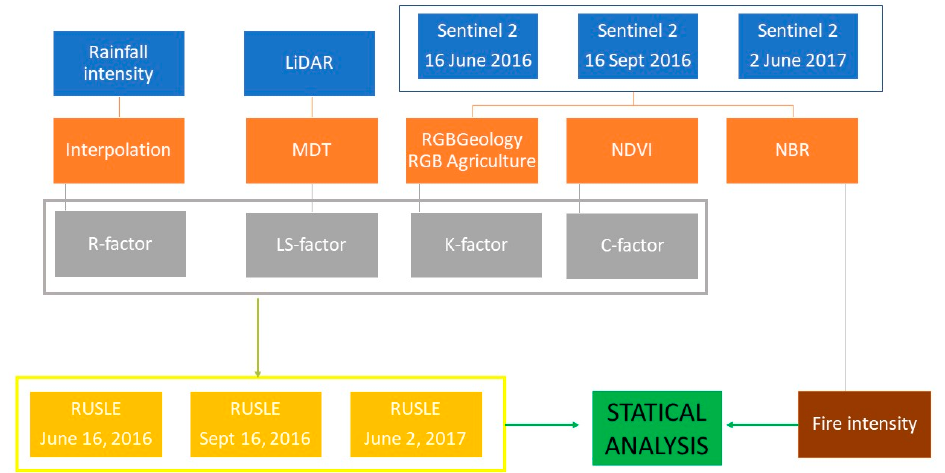
Figure 2. Workflow.